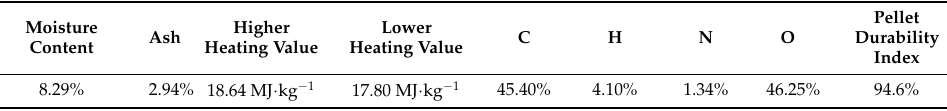
Table 3. Results of the laboratory test about pellet characterization.